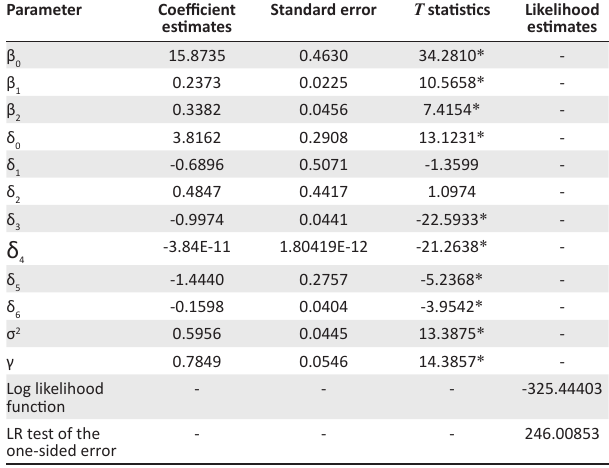
TABLE 3: Stochastic frontier analysis parameters estimation results. Parameter Coefficient